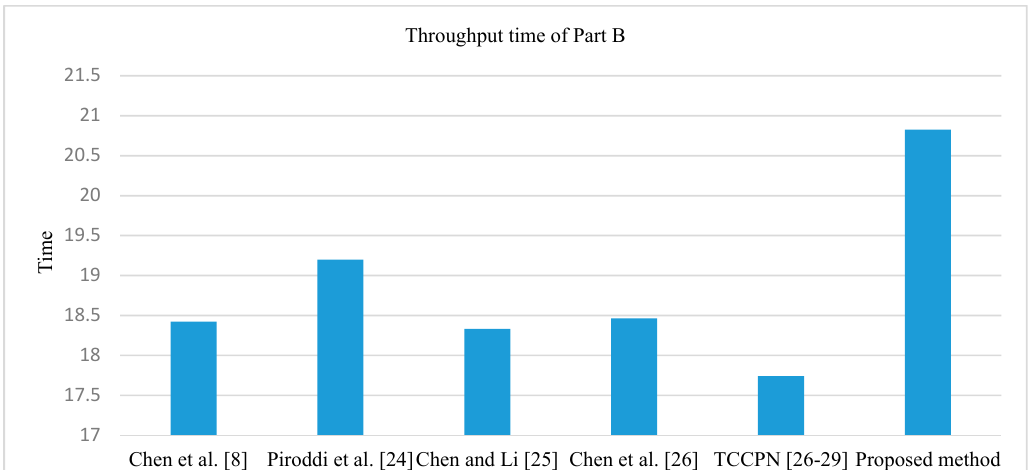
Figure 15. Comparison of throughput time of Part A for the Petri net model from Figure 11.